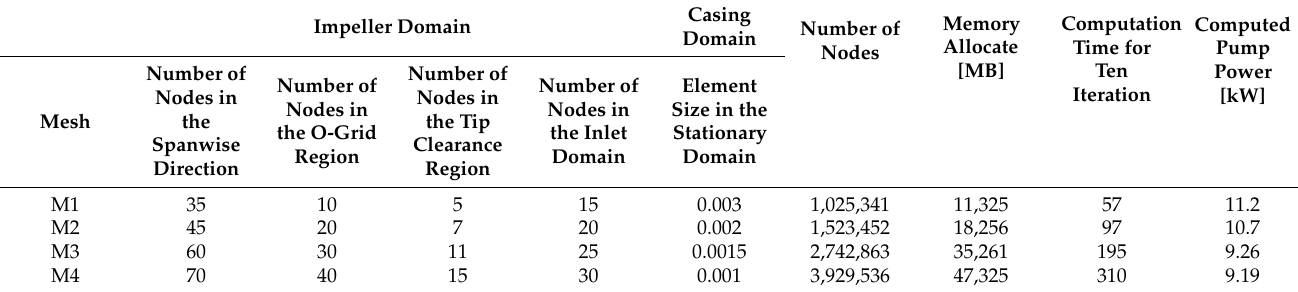
Table 8. Mesh details for mesh optimization